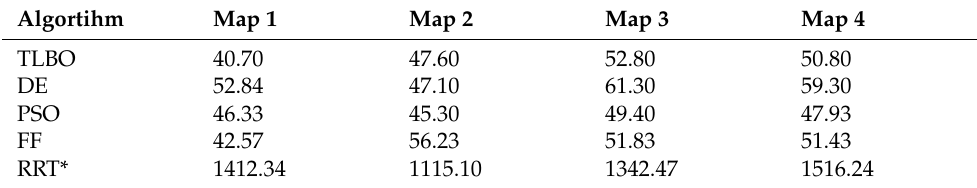
Table 4. Experimental results, mean steps to goal